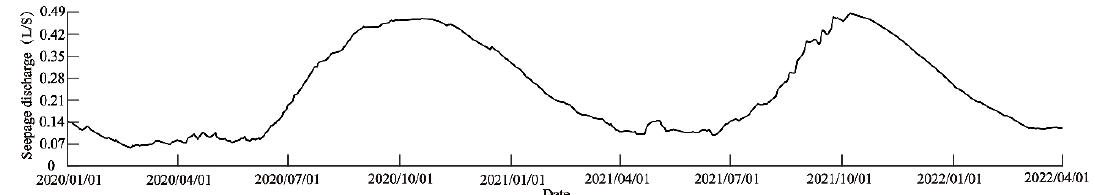
Figure 12. Process line of main water of seepage discharge at measuring point WE01ZXD.